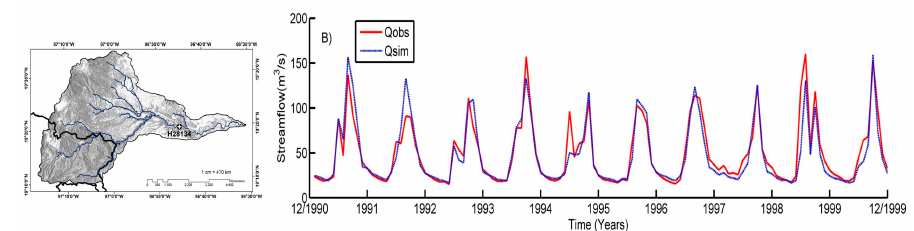
Figure 4. Monthly hydrographs of period 1 January 1990 to 31 December 1999 for hydrometric stations: ( A ) H28133 y, ( B ) H28134 in La Antigua river basin.